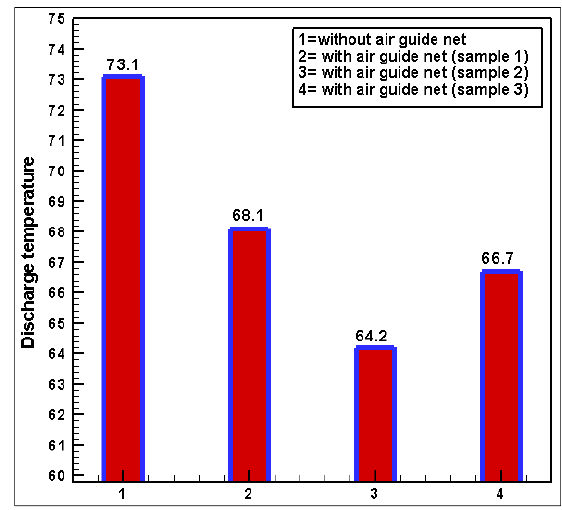
Fig. 5. Comparison of discharge temperature (T D ) between with and without air guide